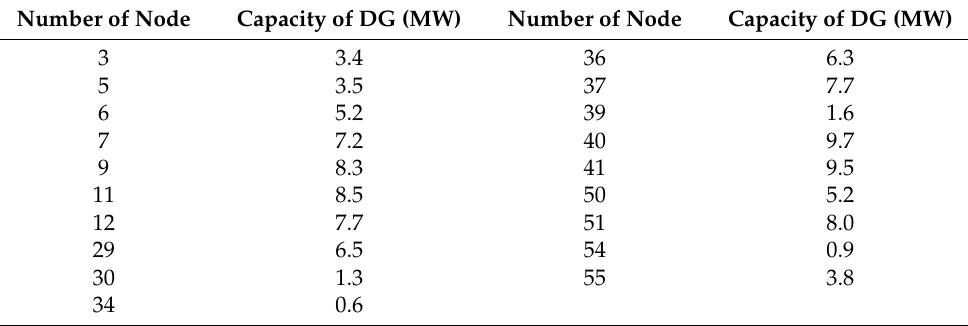
Figure 5. The Pareto frontier solution set of the acceptance capacity of DG. Table 1. The DG access scheme of the optimal compromise solution (scheme